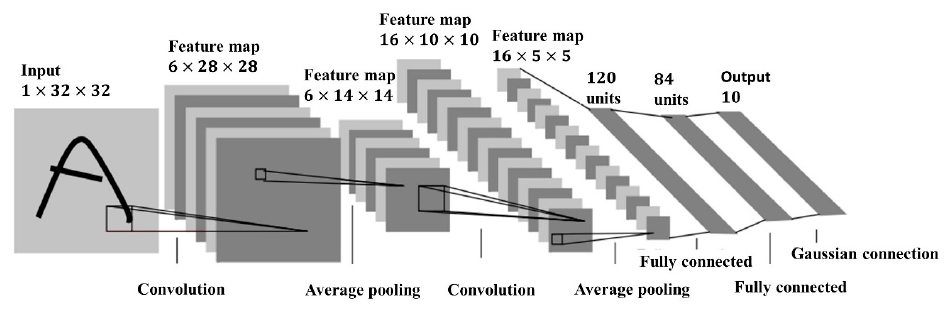
Figure 1. Architecture of LeNet-5.